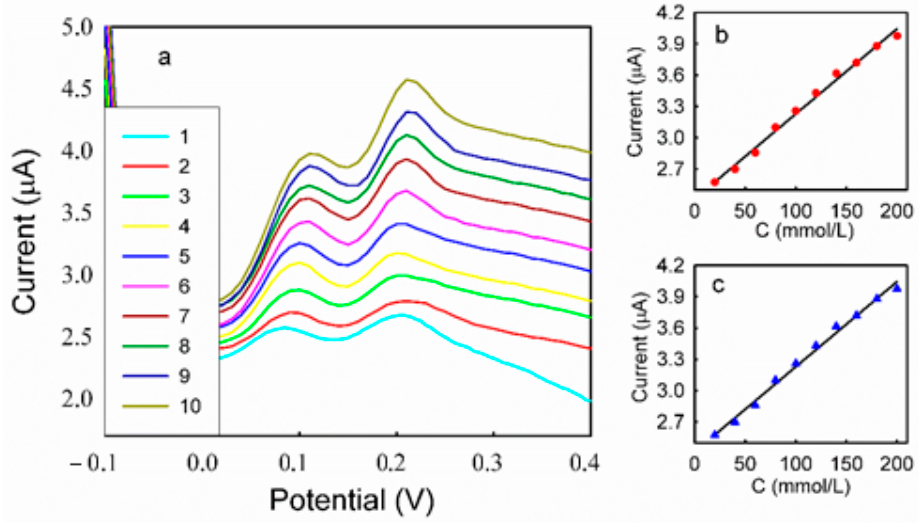
Figure 12. ( a ) DPV results of the binary mixture of CC and HQ at various concentrations on the PGDIL–TiO 2 / Au in pH = 7 PBS. ( b ) The relationship between I pHQ and C HQ . ( c ) The relationship between I pCC and C CC . Table 3. The composition of the binary mixture of CC and HQ. Concentration of Binary Mixture